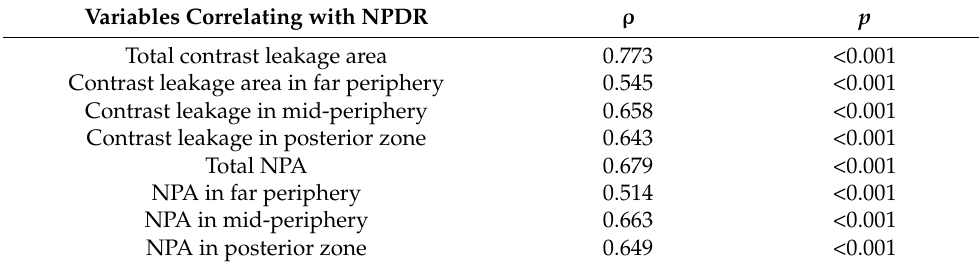
Table 5. Correlations of non-proliferative diabetic retinopathy (NPDR) with selected variables in patients ( n = 98) with diabetic macular edema (DME) before bevacizumab therapy. The results are presented as ρ Spearman’s correlation coefficients. Statistical significance was set at p <